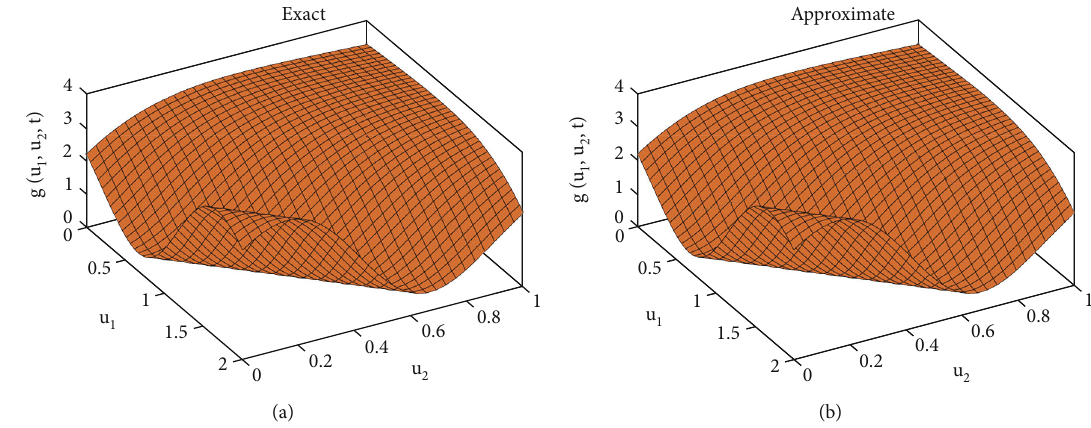
Figure 8: 3D view of the exact and approximate solution via JTDM of Example 19 for g ð u